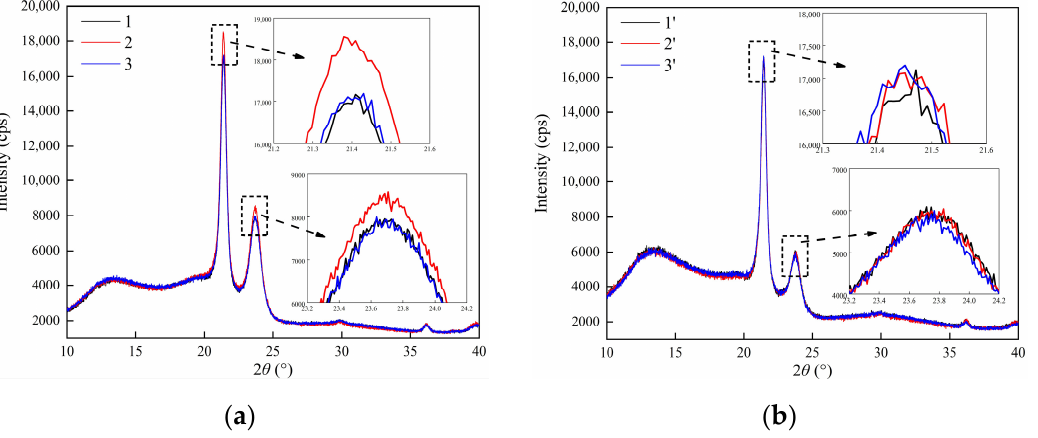
Figure 6. Lattice plane diffraction curve of three specimen positions: ( a ) H-XLPE bilayer; ( b ) XLPE.